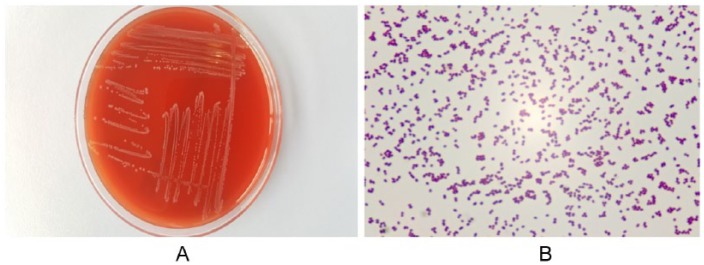
(A) Growth of colonies of Lactococcus garvieae on a blood agar plate after 48 hours of incubation in aerobic conditions. (B) Gram stain of Lactococcus garvieae with clusters and short chains of gram-positive cocci.